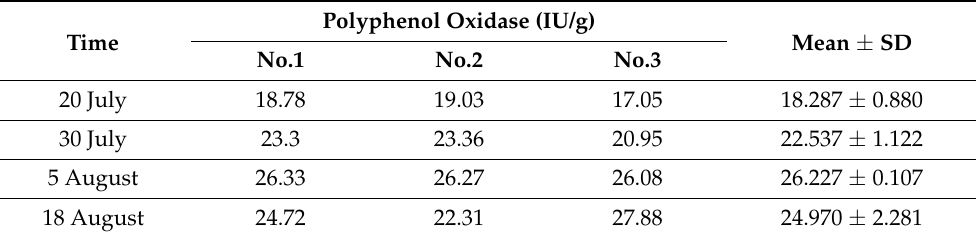
Figure 3. Changes in polyphenol oxidase in host leaves at different times of injury. Table 4. Measuring phenylalanine ammonia lyase in host leaves at different times of injury. Time